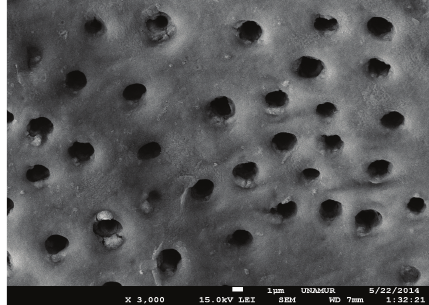
Figure 1: SEM view of unlased dentin (control) treated only with EDTA (18%) during one minute. The dentin is not covered by the smear layer. The tubules are open. Magnification: